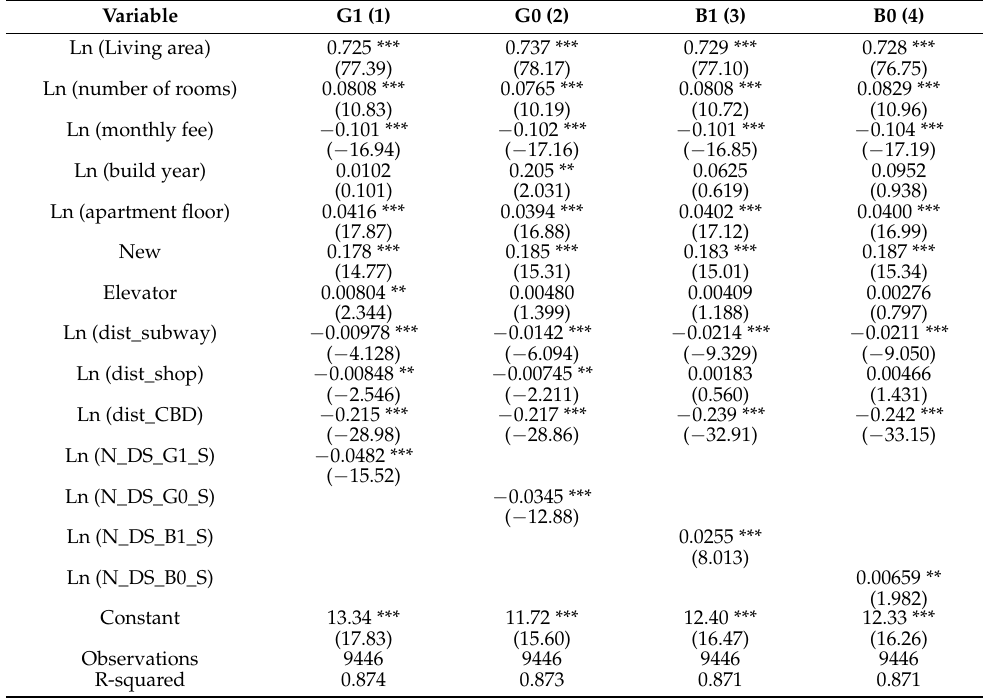
Table 5. HPM results are controlled by being close to a park for Measure